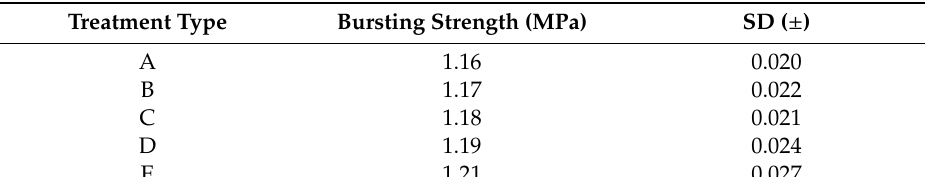
Table 5. E ff ect of finishes treatments on bursting strength (MPa). Table 5. Effect of finishes treatments on bursting strength (MPa)).